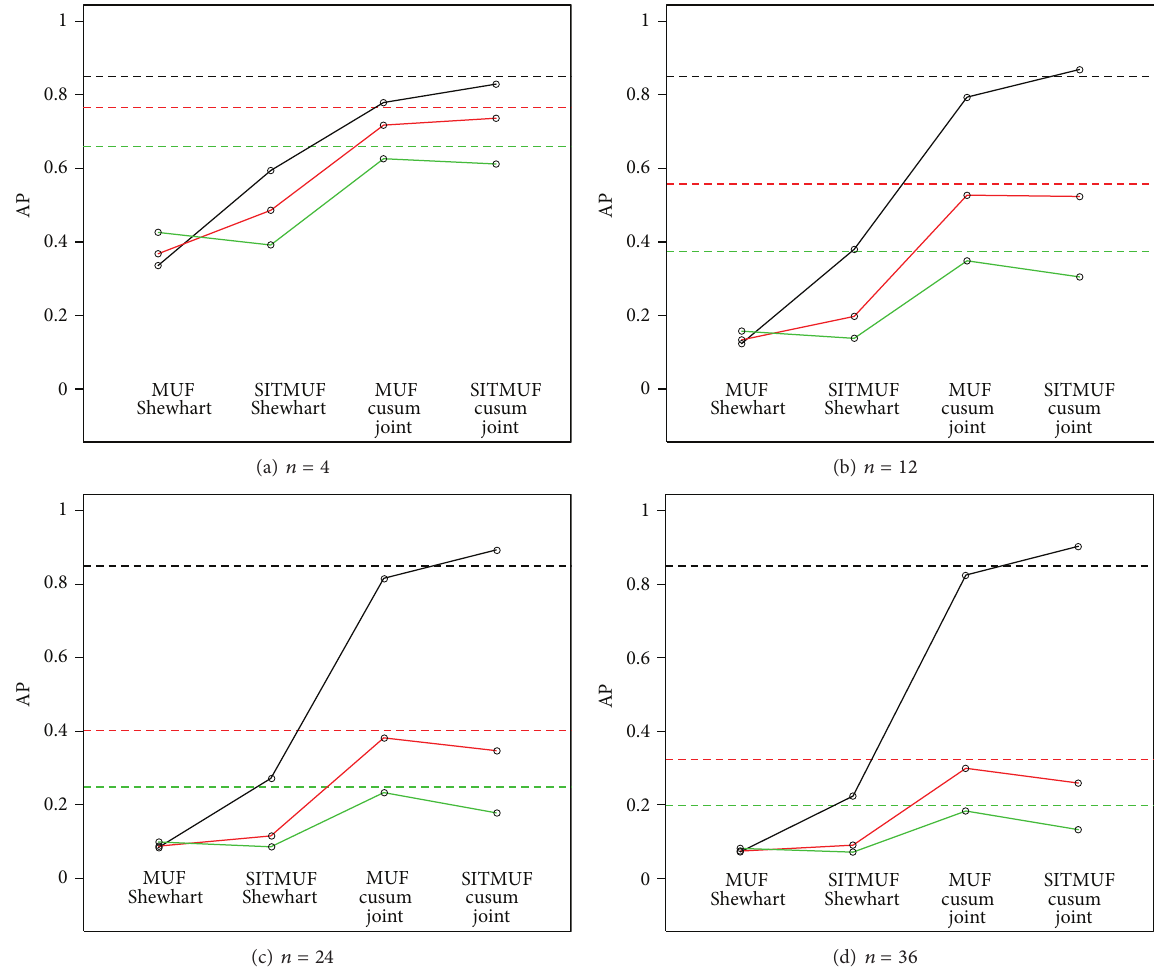
Figure 2: AP for protracted threat, 𝜎 𝑇 = 0.5 , 𝑀 = 6 . (Colors black, red, and green correspond to Σ 1 – Σ 3 . Dashed lines are for CUMUF.)